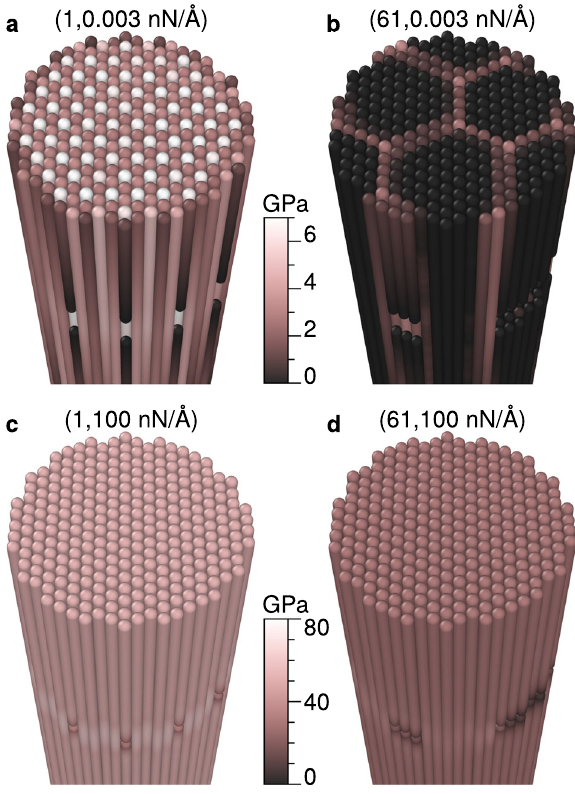
Fig. 3 Stress distribution in a polycrystalline fi ber for domains of perfectly aligned tubes ( ζ = 0). Stress distribution in the fi ber during tensile loading simulations right before critical failure for select combinations of size and friction ( n , f ), as indicated by the corresponding numerical values. Note that the colorbars for a , b and c , d have different ranges to make the stress distribution clearly visible.